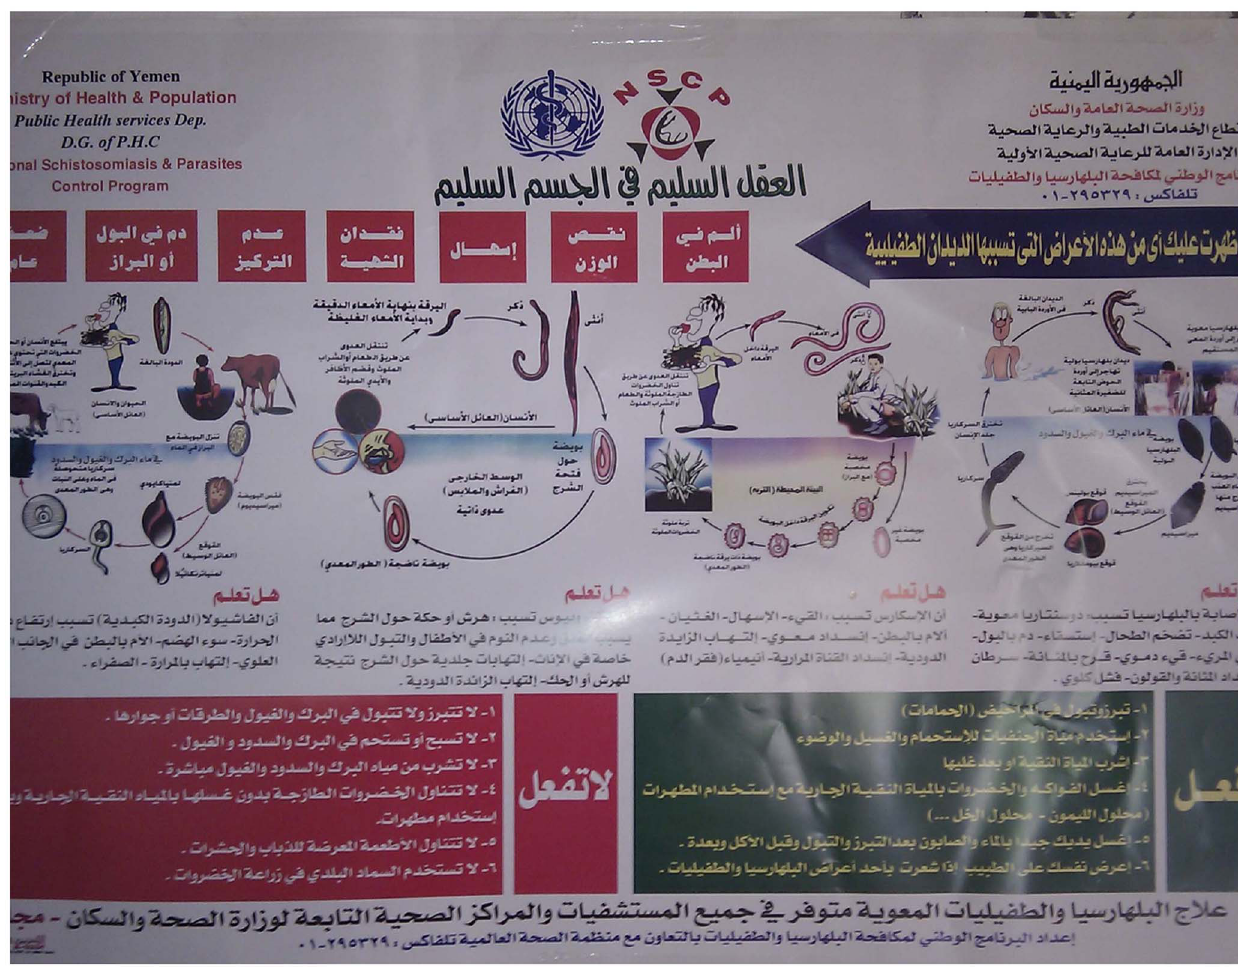
Fig. 2. Schistosomiasis treatment campaign. 2010 informational poster from Yemen’s National Schistosomiasis Control Program depicting the disease transmission cycle for schistosomiasis and providing information about both prevention and treatment. doi:10.1371/journal.pntd.0003292.g002 PLOS Neglected Tropical Diseases |